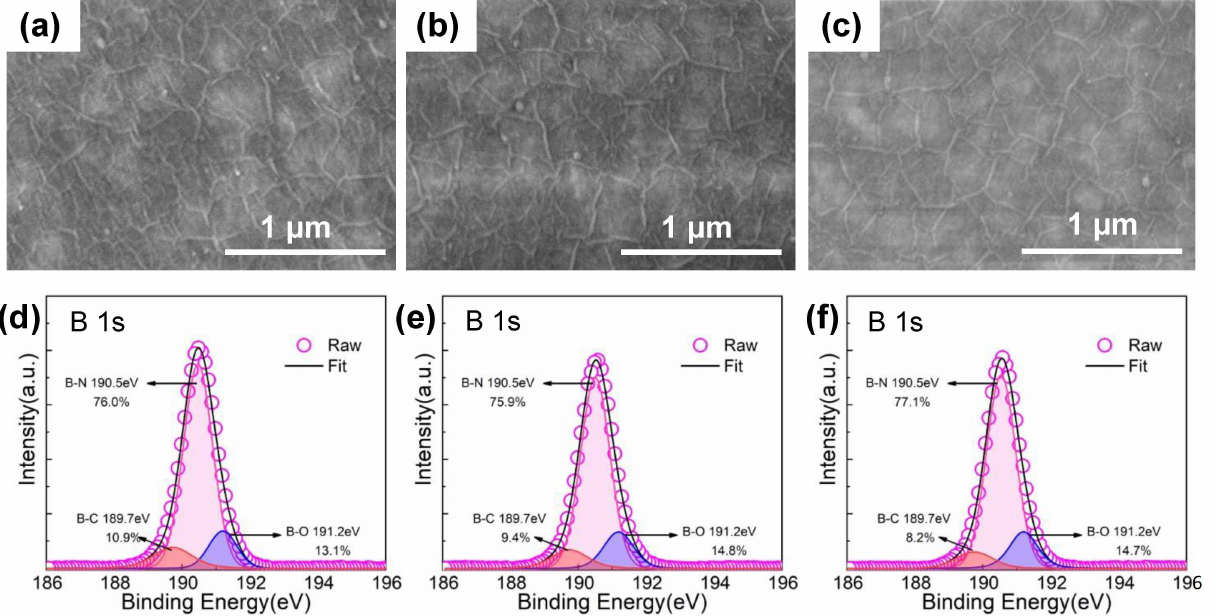
Figure 6. The SEM images and XPS spectra of h-BN films with different NH 3 injection durations under NH 3 /Itrp/TEB/Itrp modes: ( a , d ) 2 s, ( b , e ) 4 s and ( c , f ) 12 s. The TEB injection duration and the growth loop were kept 2 s and 150,